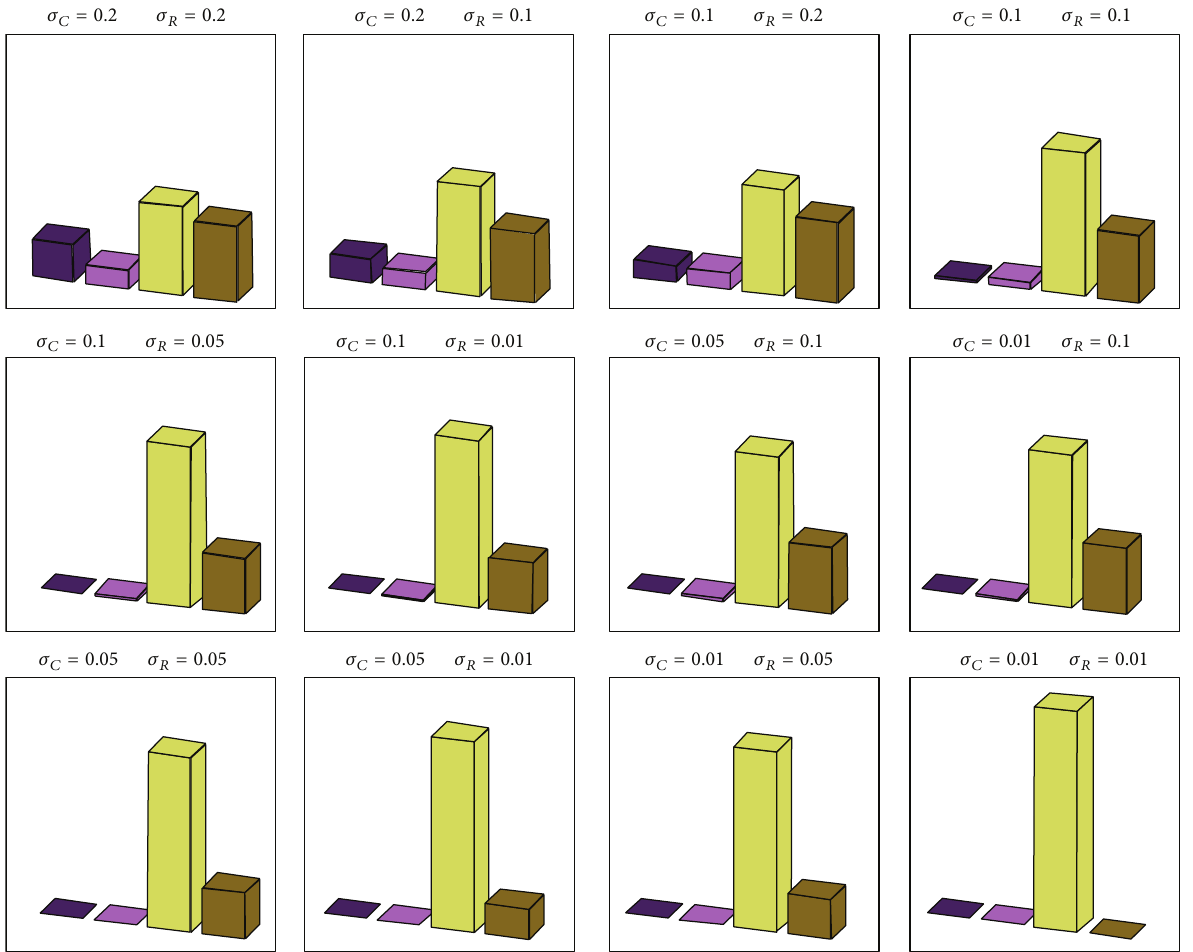
100 %. Dark magenta